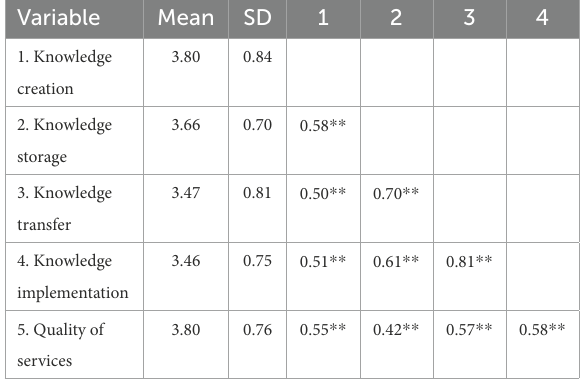
TABLE 2 Mean values, standard deviations, and coefficient correlations ( n =